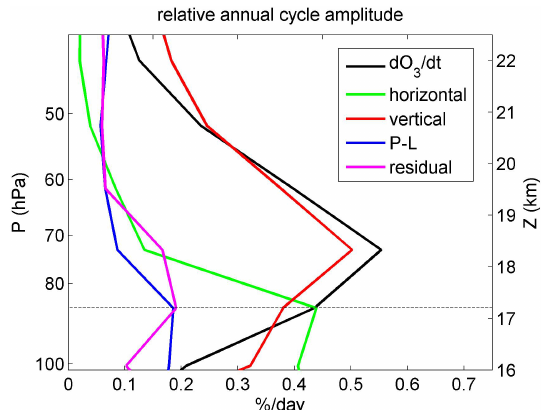
Fig. 11. Vertical structure of the annual cycle amplitude of the terms in the TEM continuity equation for ozone concentration (Eq. 5) av- eraged over 18 ◦ S–18 ◦ N. Relative amplitudes are obtained divid- ing by the annual mean concentration. The approximate altitude is calculated as for Fig. 1. The dashed horizontal line indicates the location of the annual mean cold point tropopause in